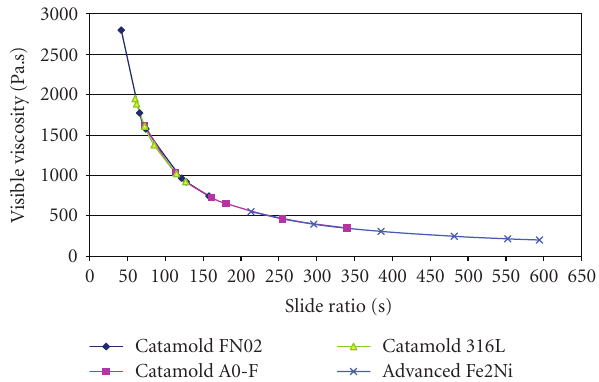
Figure 8: Slide ratio versus visible viscosity for present feedstocks (load 1878 MPa).